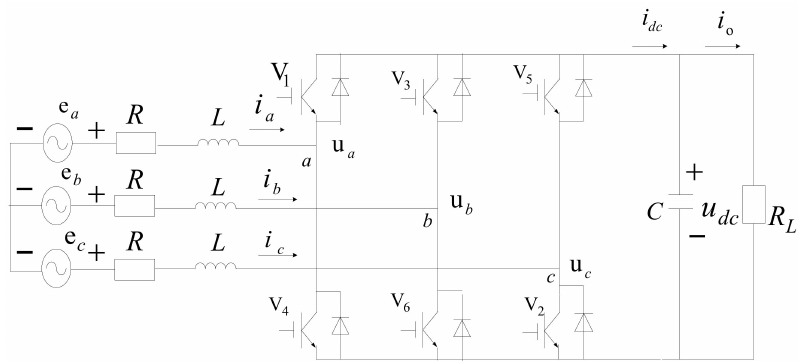
Figure 2. Topological structure diagram of photovoltaic grid-connected